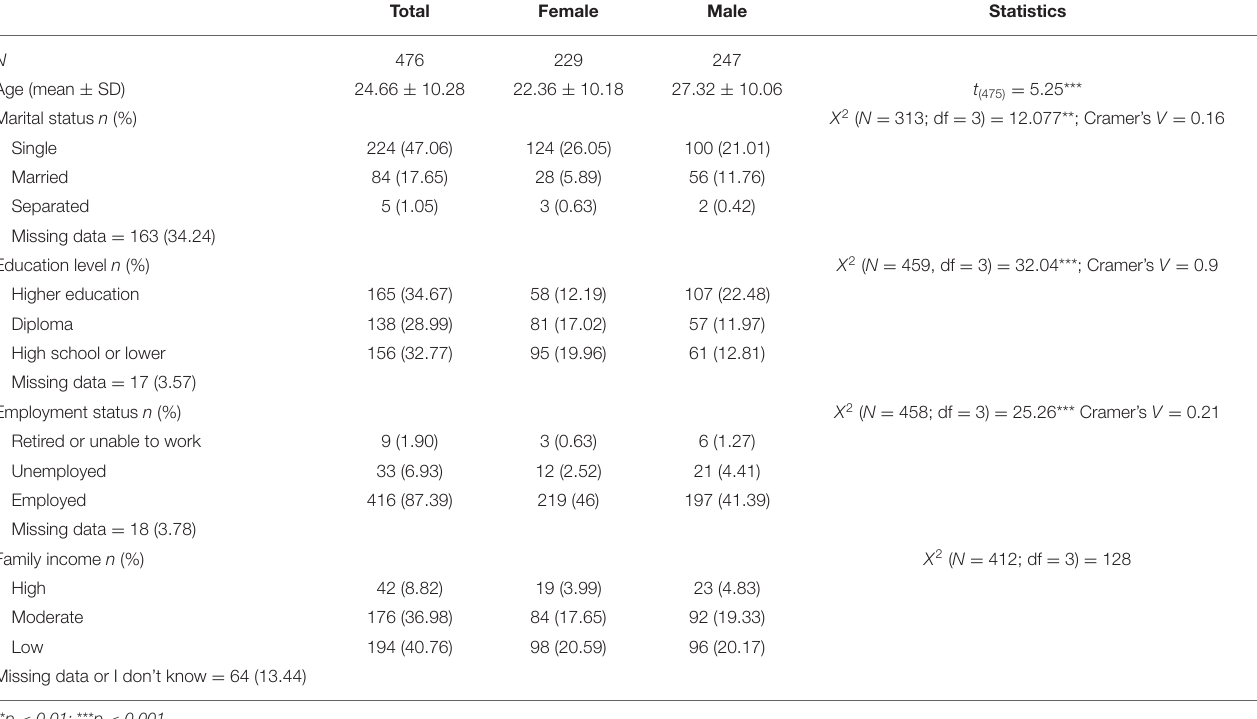
TABLE 1 | Participants’ demographic characteristics, separately for male and female participants.